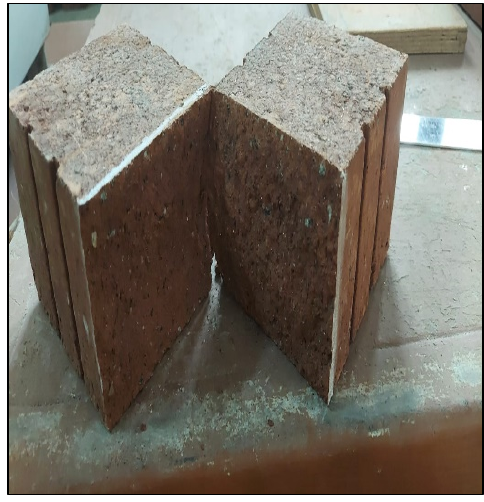
Figure 20. Failure of brick after split tensile strength test.